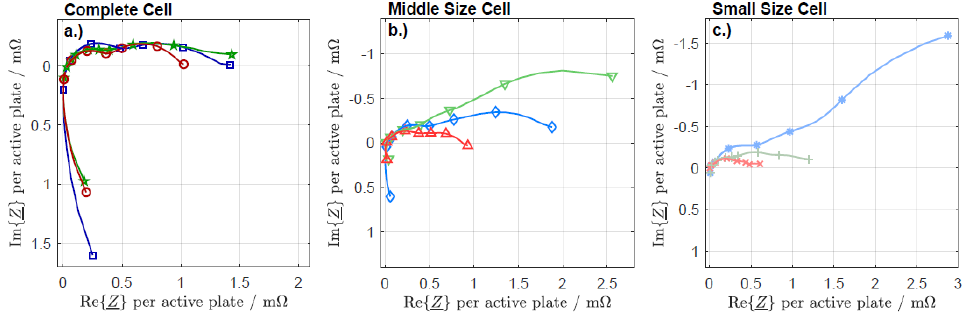
Figure A1. Complete, unprocessed negative half-cell EIS at 80% SoC for ( a ) complete cell: 8P8N/8P9N, ( b ) middle size cell: 3P2N and ( c ) small size cell: 2P1N visualized in a Nyquist diagram.